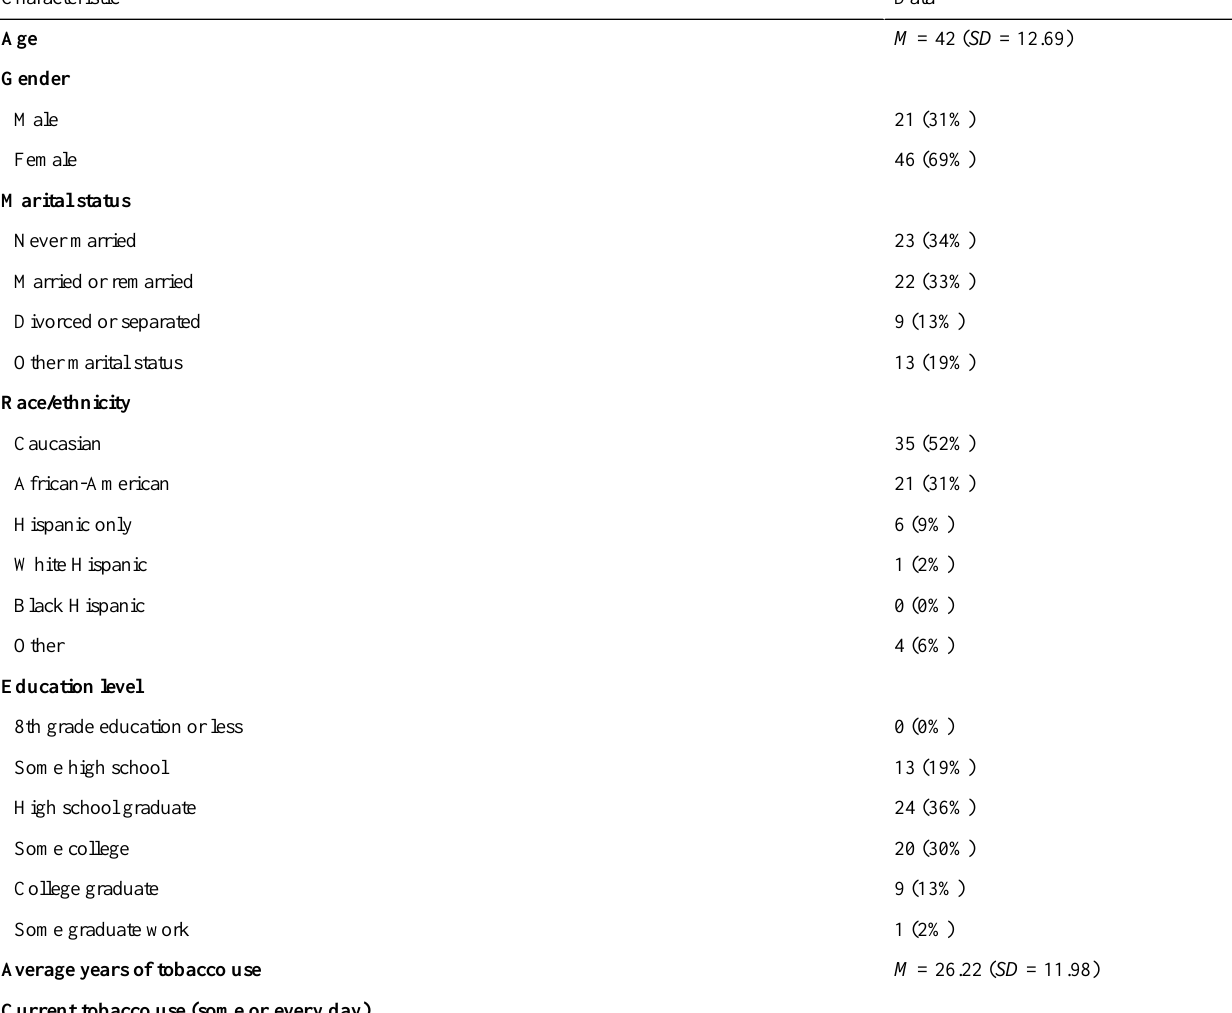
Table 2. Demographic and smoking characteristics of participants who completed the CABIT program (n =